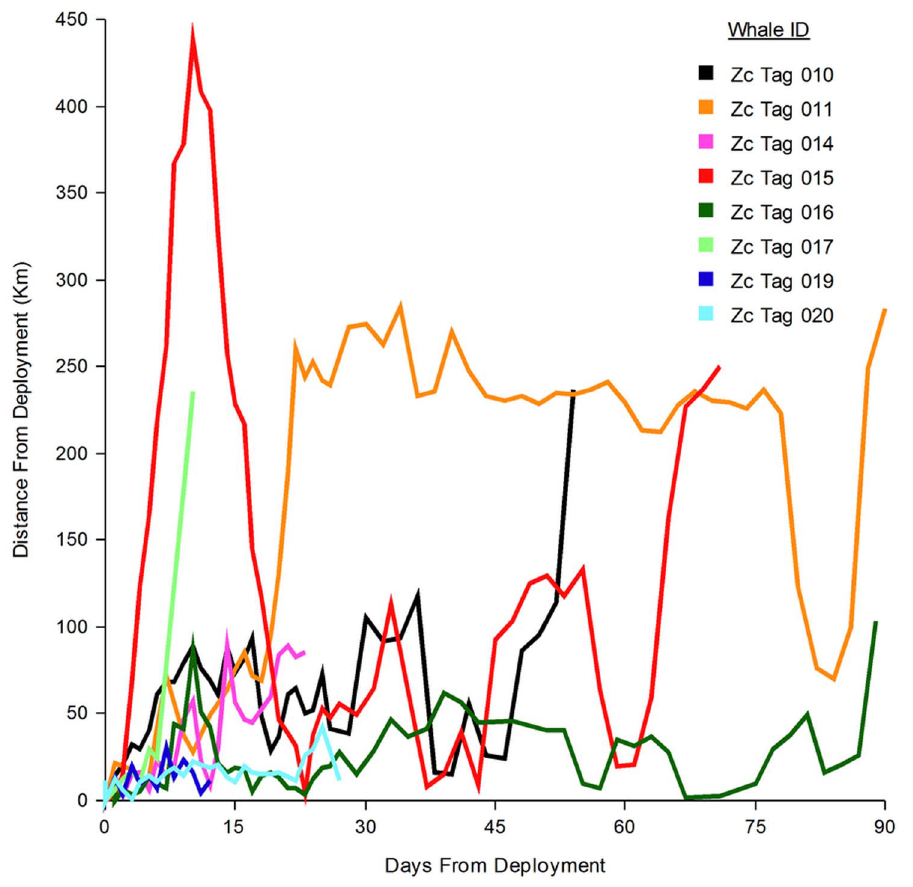
Figure 5. Distance to deployment location from day of deployment, by individual. Distance from deployment was calculated using the best location per day, as determined by the Douglas Argos Filter [14]. All individuals were tagged on the SOAR MFA sonar training range, and most remained in close proximity to the area in which they were tagged. While Zc015 made an extra-regional excursion over 450 km away, she returned to within 5 km of her tagging location.